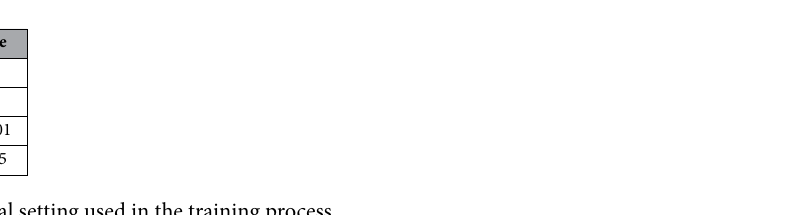
Table 1. Experimental setting used in the training